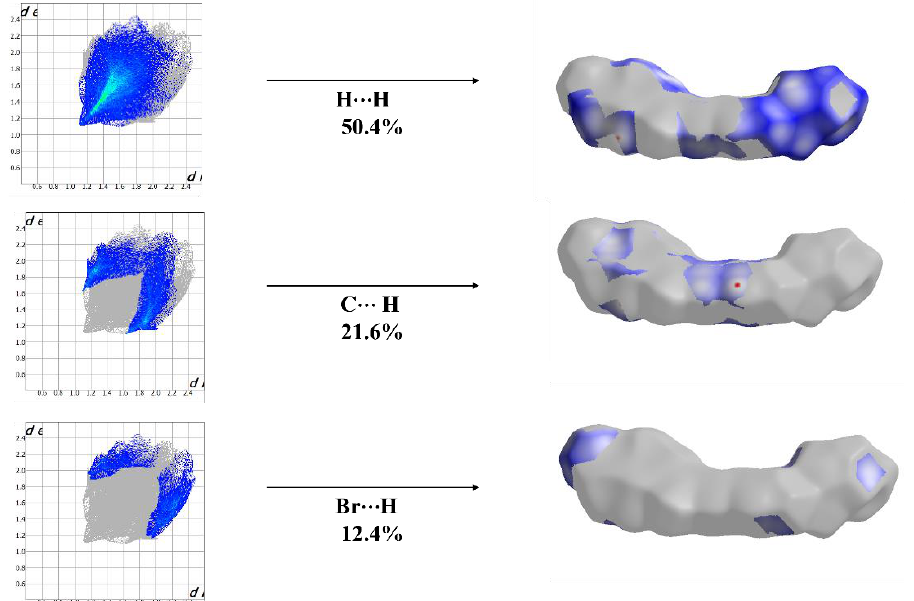
Figure 13. Hirshfeld surface diagram and two-dimensional fingerprint plots of the nearest internal distance (di) versus the nearest external distance (de) for major interactions in